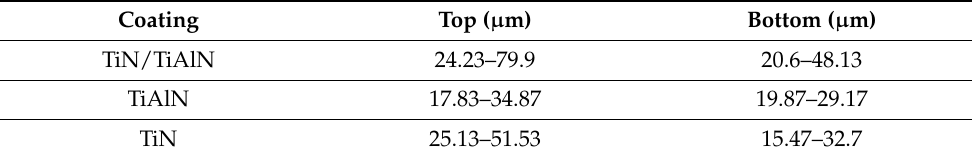
Table 6. Range of hole-size deviation for each tool coating.